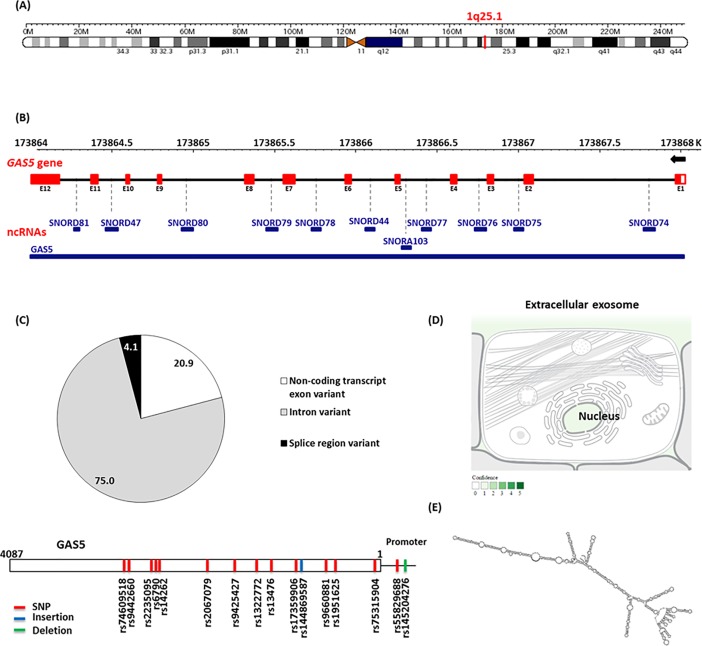
Structural analysis of GAS5 gene.(A) Chromosomal localization of GAS5 gene. It is present on chromosome 1q25.1, at genomic coordination 1:173863901–173867987 on the negative strand (according to human genome assembly GRCh38). (B) Sequence analysis of GAS5 gene. It consists of 12 exons, spanning 4.087 kb that code for 29 different alternative splice transcripts. It hosts multiple snoRNA genes within its introns (except intron 9). These genes encode for ten C/D box snoRNAs, which contain the C (UGAUGA) and D (CUGA) box motifs, and an H/ACA box snoRNA, SNORDA103, within intron 4. (C) Genetic variant analysis. GAS5 gene (4087 bases long) contains around 300 thousand variants (75% intronic, 21% exonic, and 4% splice region polymorphisms). Among all these polymorphisms, 14 SNPs (red), one deletion (green) and one insertion (blue) are common variants with minor allele frequency (MAF) > 0.05. (D) Subcellular localization of lncRNA GAS5. Text mining highlighted its predominant existence intranuclear and within extracellular exosomes which are extruded into the circulation. (E) Folding pattern of lncRNA GAS5. [Data source: Ensembl.org, genecards.org, NCBI, COMPARTMENT database, and MFold].